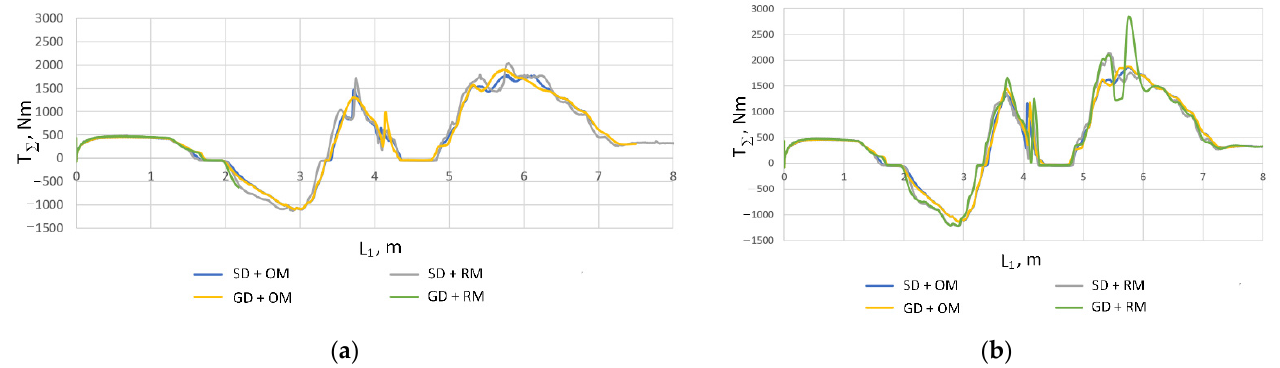
Figure 17. Changes in the value of the sum of driving torques on the road wheels during the simulation when the vehicle model was driven through the ditch at the maximum value of the coefficient of adhesion φ = 0.3 ( a ) and φ = 0.7 ( b ): GD—gear-type flow divider, SD—spool-type flow divider, OM—orbital motor, RM—radial piston motor.